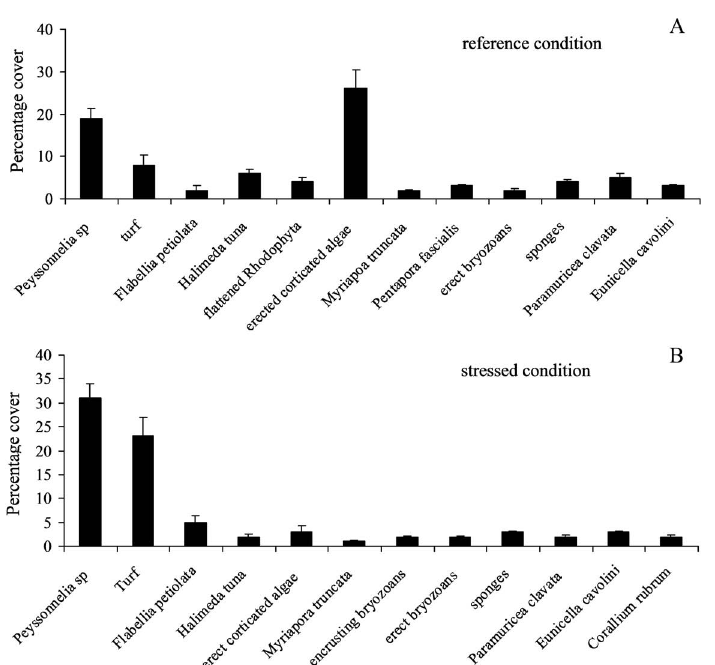
Fig . 2. – Percentage cover (mean±SE, n=12) of the main taxa/morphological groups (mean percentage cover greater than 2) in coralligenous assemblages. Encrusting Corallinales showed a cover of 100% and they are not considered in the